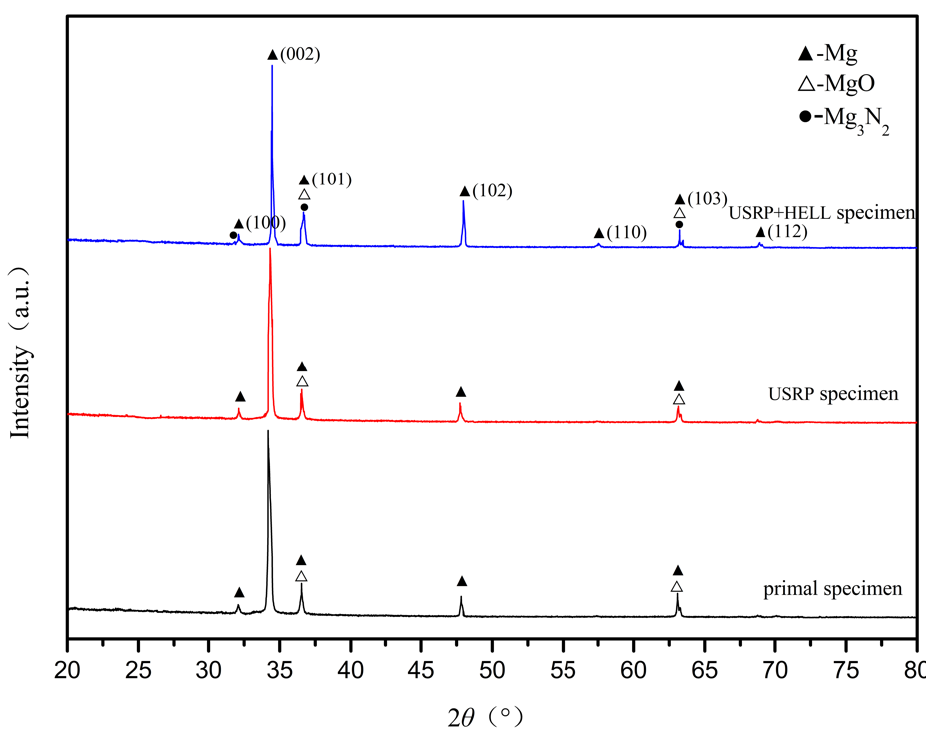
Figure 1. XRD patterns of magnesium alloy samples treated by different processes.